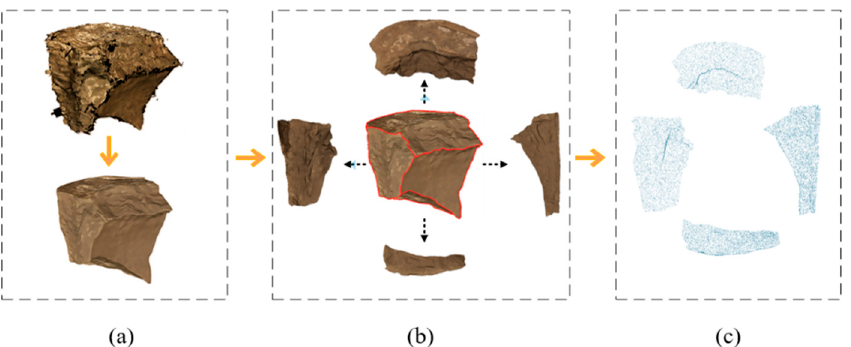
Figure 2. Flow chart of data processing. ( a ) Fragment denoising; ( b ) fracture surface extraction; ( c ) random sampling result.